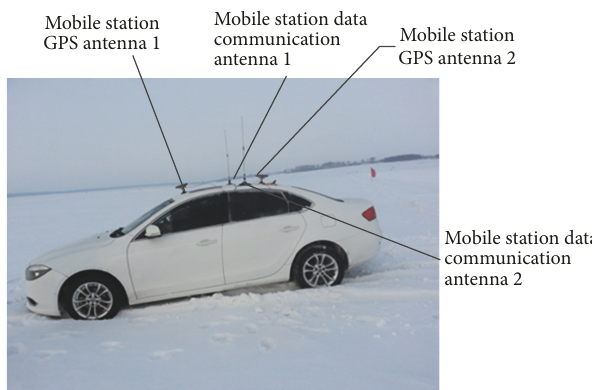
Figure 8: Arrangement of sideslip angle measurement system based on GPS.